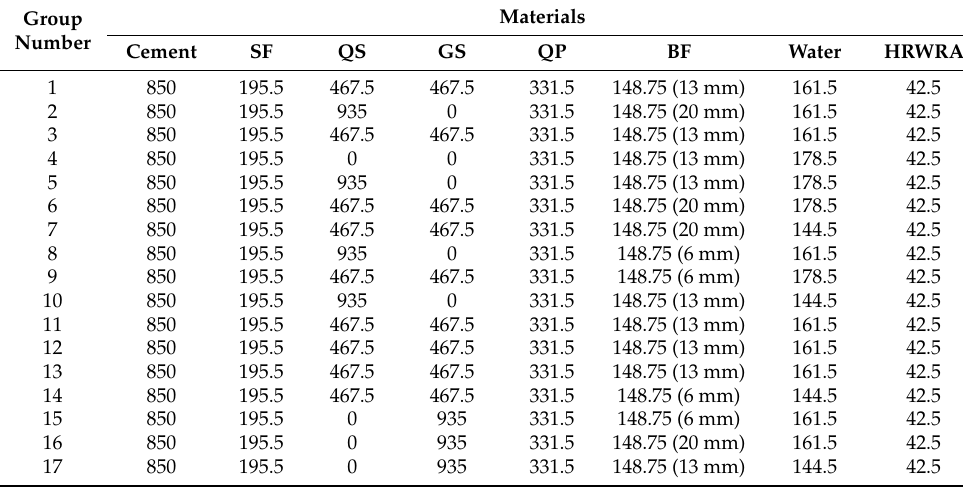
Table 1. Concrete mix design (kg/m 3